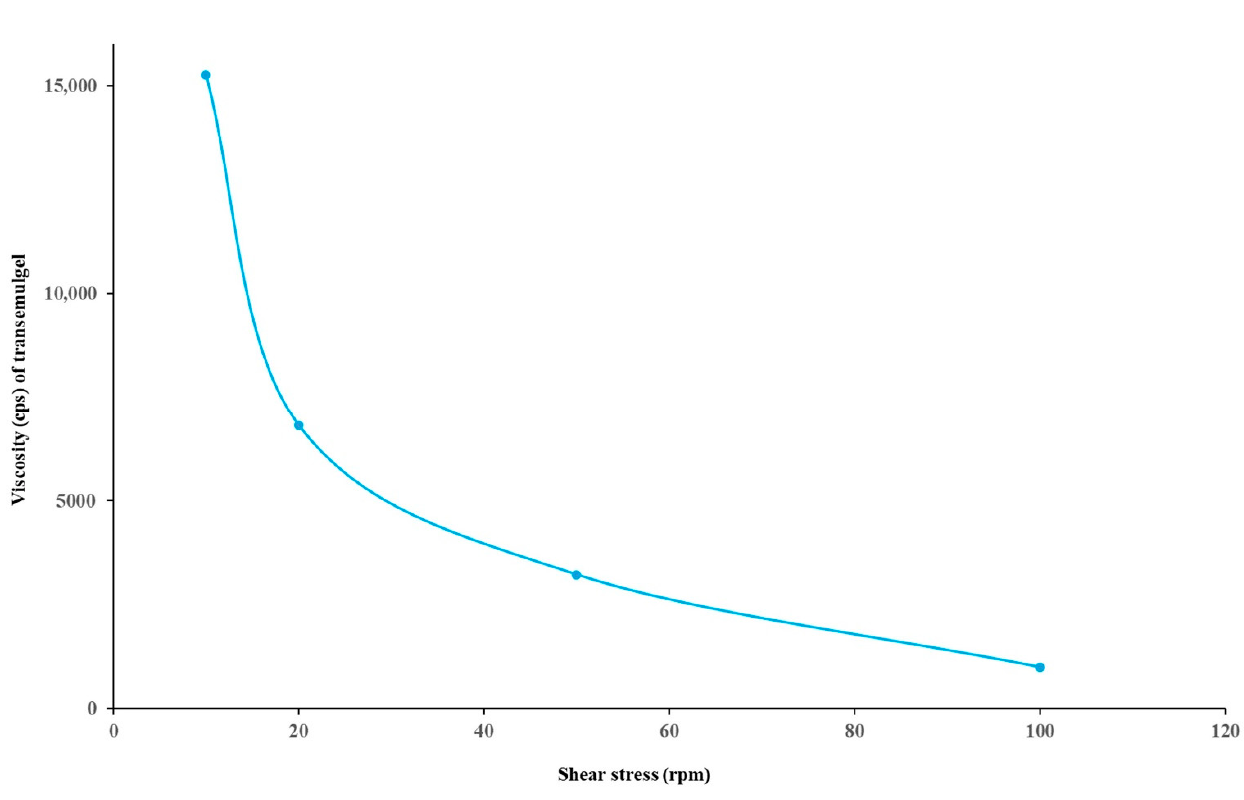
Figure 8. The viscosity of optimized transemulgel (MM10). Figure 8 . The viscosity of optimized transemulgel (MM10).